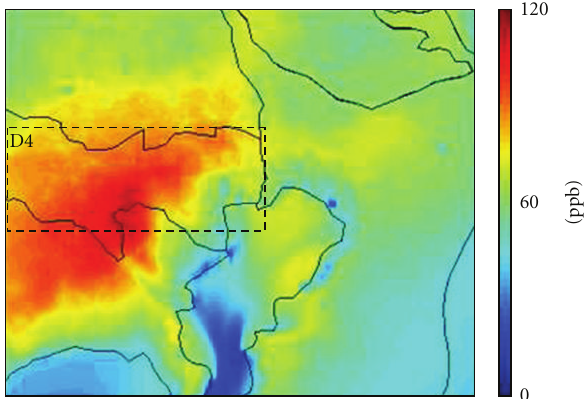
Figure 11: Geopotential height (gpm) and wind at 850mb at 9:00 JST on August 4, 2005.